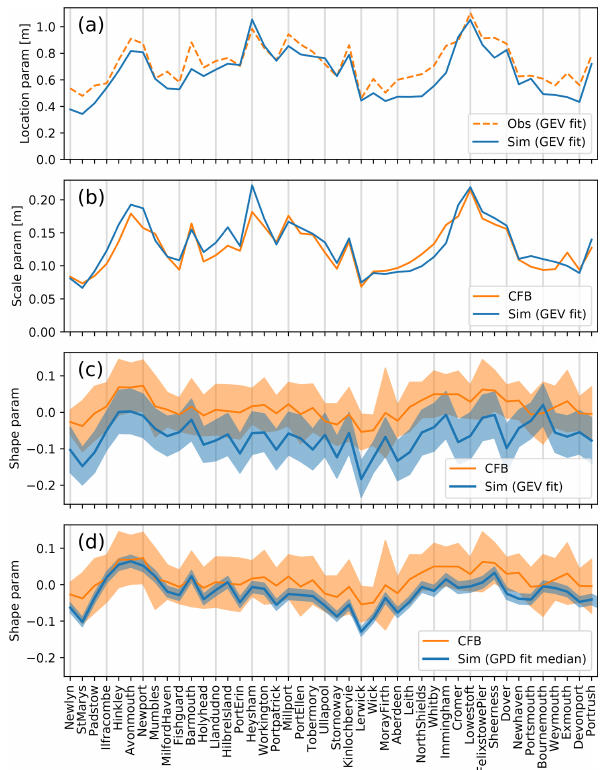
Figure 2. Comparison of simulation-based and observation-based skew surge extreme value distribution parameters. (a) Location pa- rameter. (b) GEV scale parameter ( σ ). (c, d) Shape parameter. The correlation seen in all panels shows that the model successfully sim- ulates the observed spatial variations in the extremes. Pointwise un- certainties in the estimated shape parameters are included in pan- els (c) and (d) . The CFB uncertainty shown is the 95% confidence interval of the GPD fit at a 95% threshold. In panel (d) (the last panel), the simulation uncertainty shown is evaluated in the same way. In panel (c) (next-to-last), the simulation uncertainty shown is the 95% confidence interval of the GEV fit to the simulated annual maxima. For further details see the main